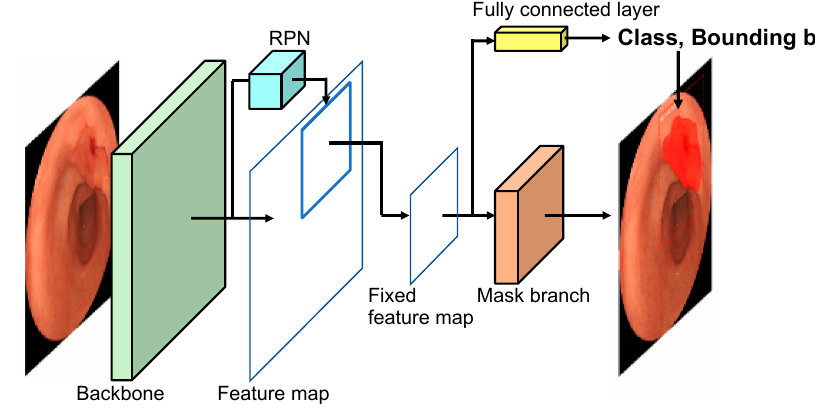
Figure 2. Network Figure 2. Network architecture.